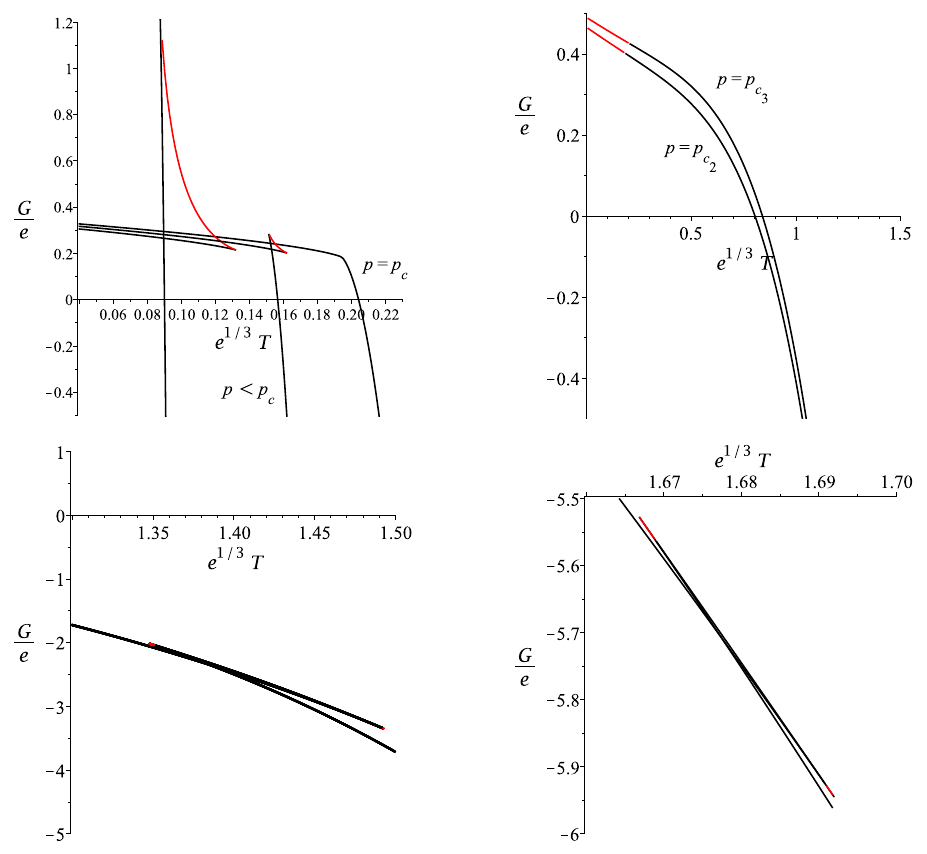
Figure 13 . Free energy of six dimensional spherical black holes (colour online). Plots of the Gibbs free energy for P = P c , 0 : 6 P c and 0 : 2 P c (top left), for P = P c 1 : 12585 P c (bottom left) and for P = 0 : 97639 P c 2 very sharp swallowtails. In all cases red lines indicate negative speci(cid:12)c heat. For the choice of e = 1, (cid:12) 3 = (cid:0) 3 = 5 e 4 = 3 and (cid:11) 4 = (cid:0) 4 = 5 e 2 , we have P c P c e 2 = 3 (cid:25) 0 : 3